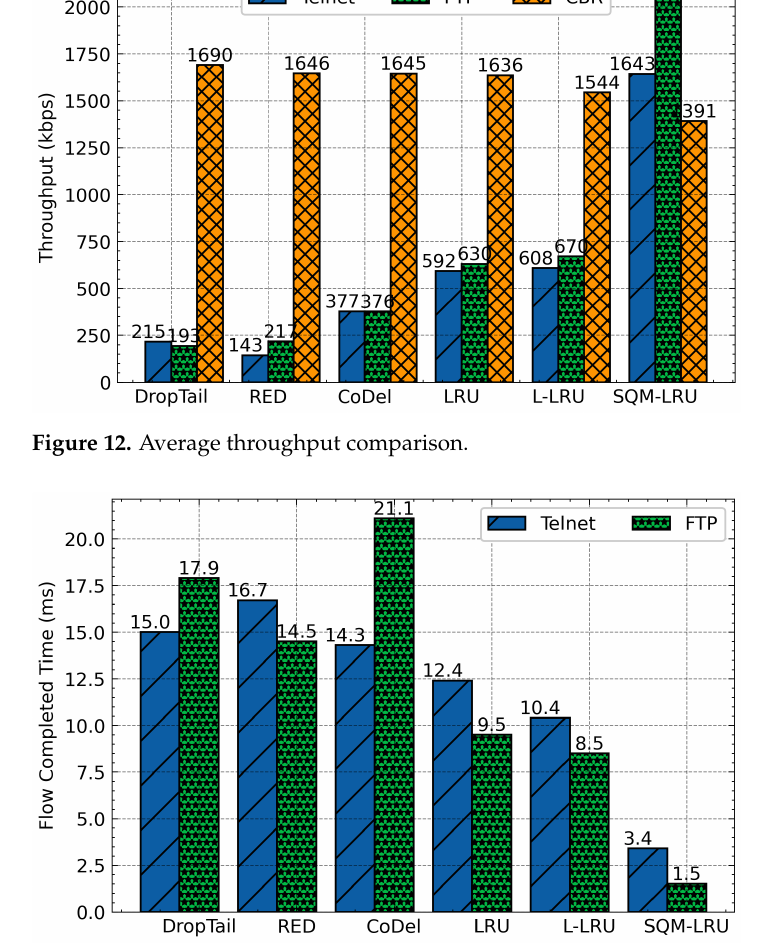
Figure 13. Comparison of average